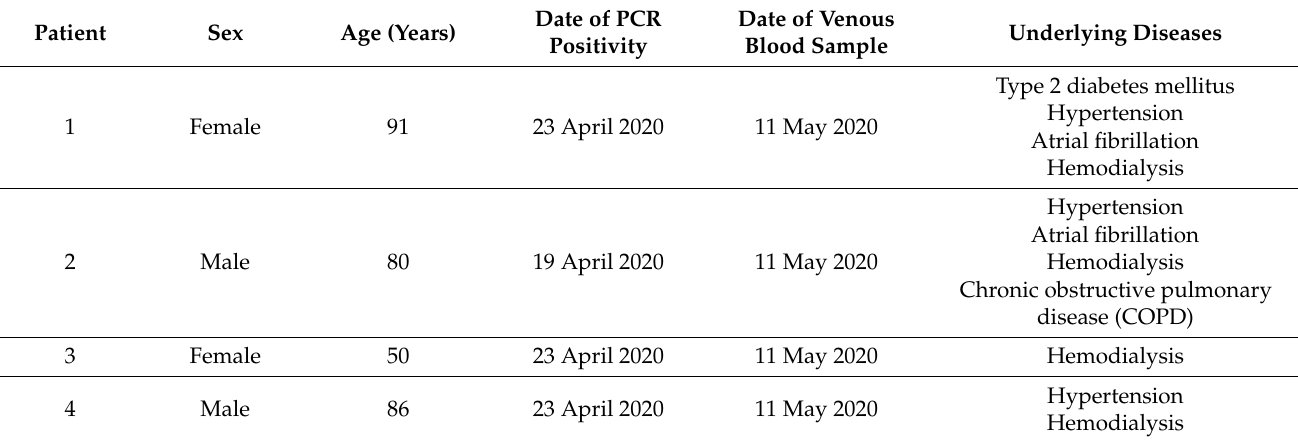
Table 1. Patients’ personal and medical